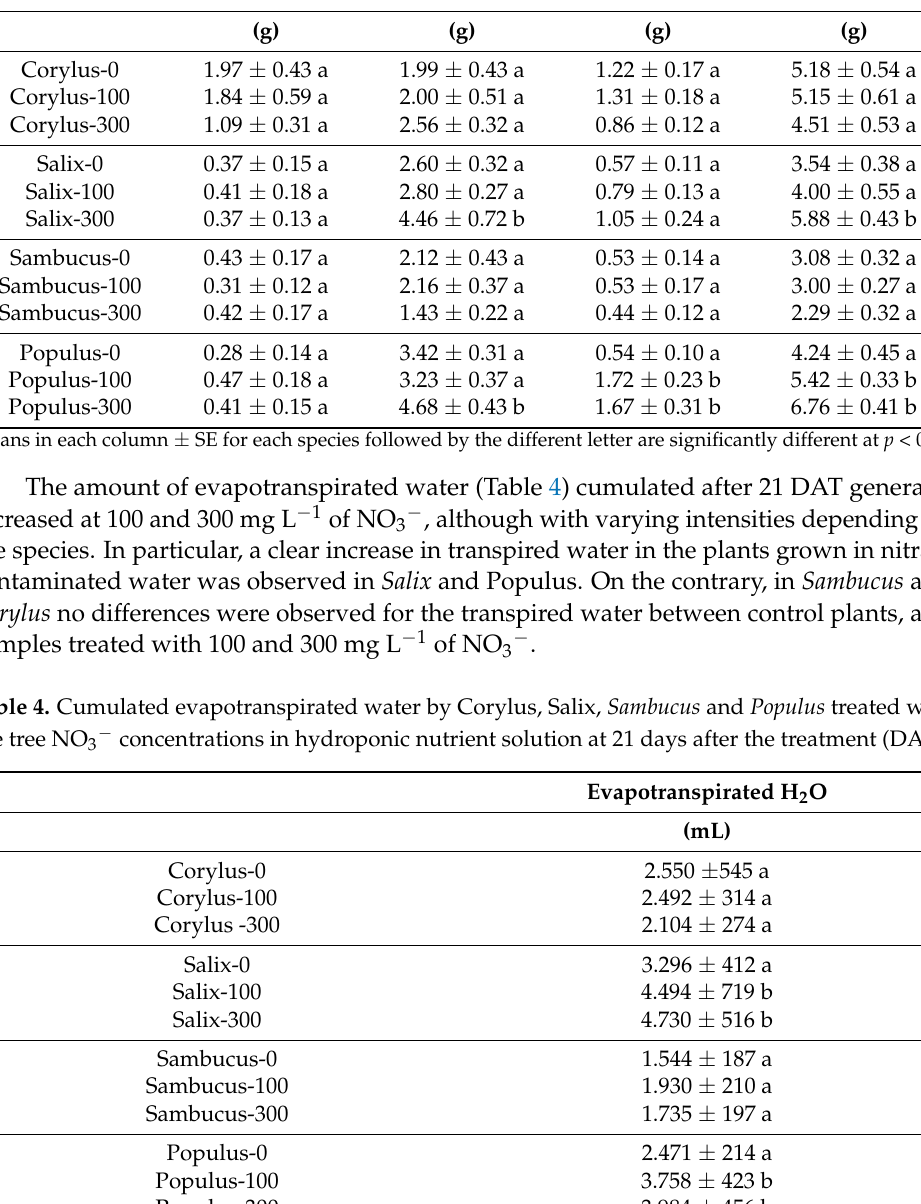
Means in each column ± SE for each species followed by the different letter are significantly different at p <